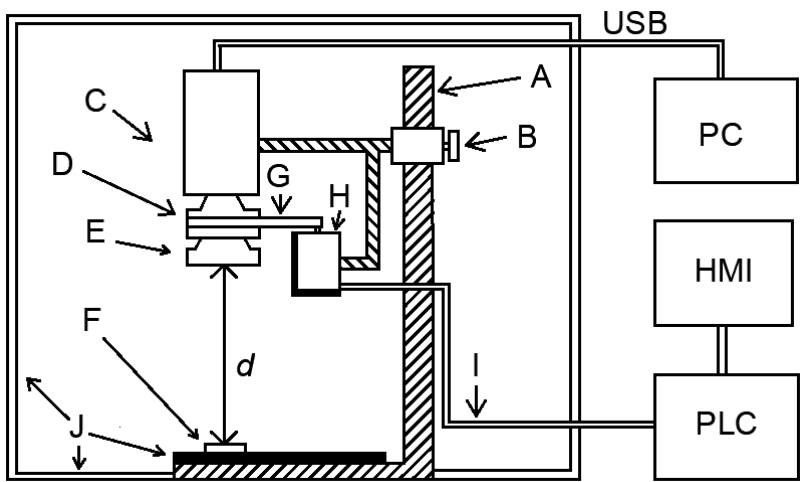
Figure 2. Measurement system: ( A ) Tripod; ( B ) Height adjustment with micrometer screw; ( C ) Thermal imaging camera; ( D ) Thermal imaging camera lens; ( E ) Additional macro lens; ( F ) Observed object; ( G ) Rubber strap; ( H ) Stepper motor; ( I ) Wire between the engine and the measurement system; ( J ) Polyurethane foam.